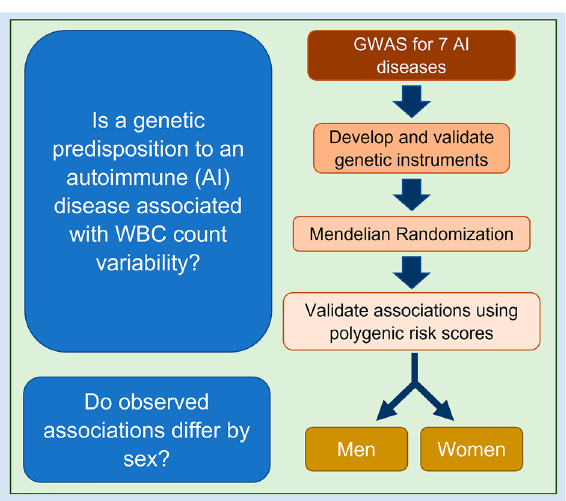
Figure 1. Summary of the research question and study design. Summary level data from genome-wide association studies (GWAS) were extracted for 7 autoimmune (AI) diseases to develop and validate genetic instruments by testing their association with the respective AI disease in BioVU using disease-specific polygenic risk scores (PRS) and PheCodes. Validated instruments were used as exposures in the Mendelian randomization (MR) analyses to test the genetic association between AI diseases and white blood cells (WBCs). Significant association in the MR analyses were validated by testing the association between disease specific PRS and transformed measured WBC counts in ARIC and BioVU. Stratified analyses by sex were performed to measure the magnitude of association in males and